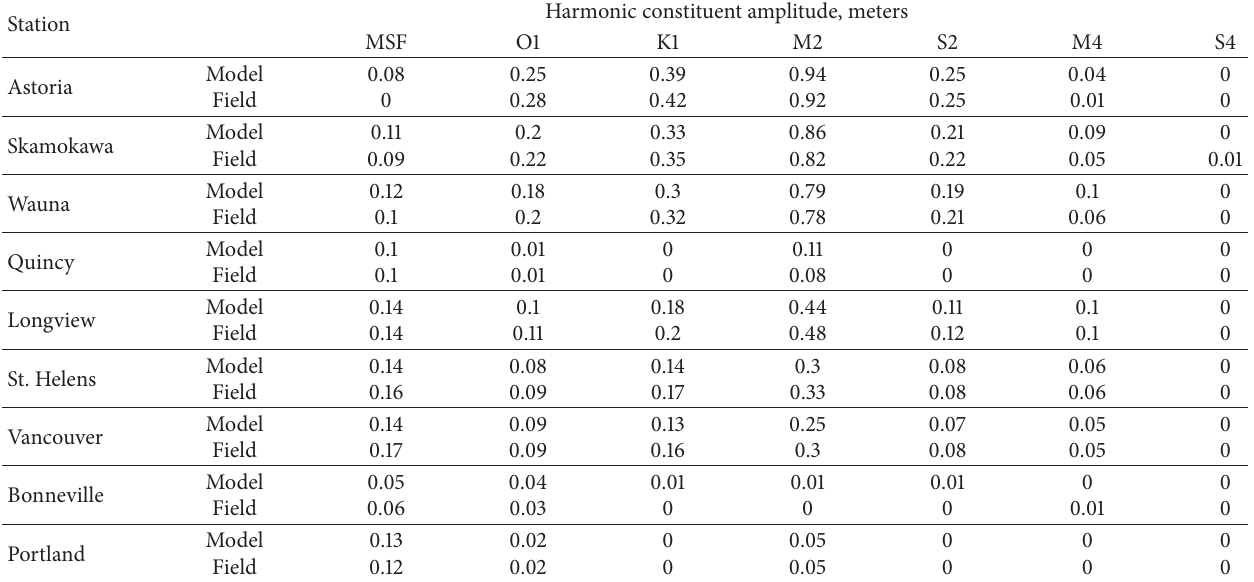
Table 1: Harmonic constituent analysis.